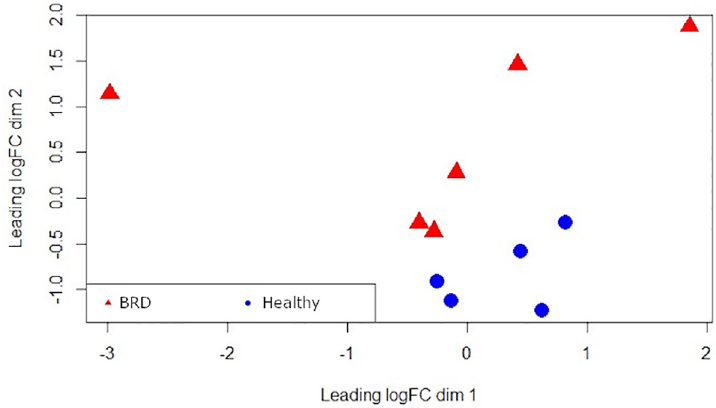
Fig 2. Multi-dimensional scaling (MDS) plot of the gene count data set from all 11 samples. Red triangles indicate BRD cattle. Blue circles indicate healthy cattle.